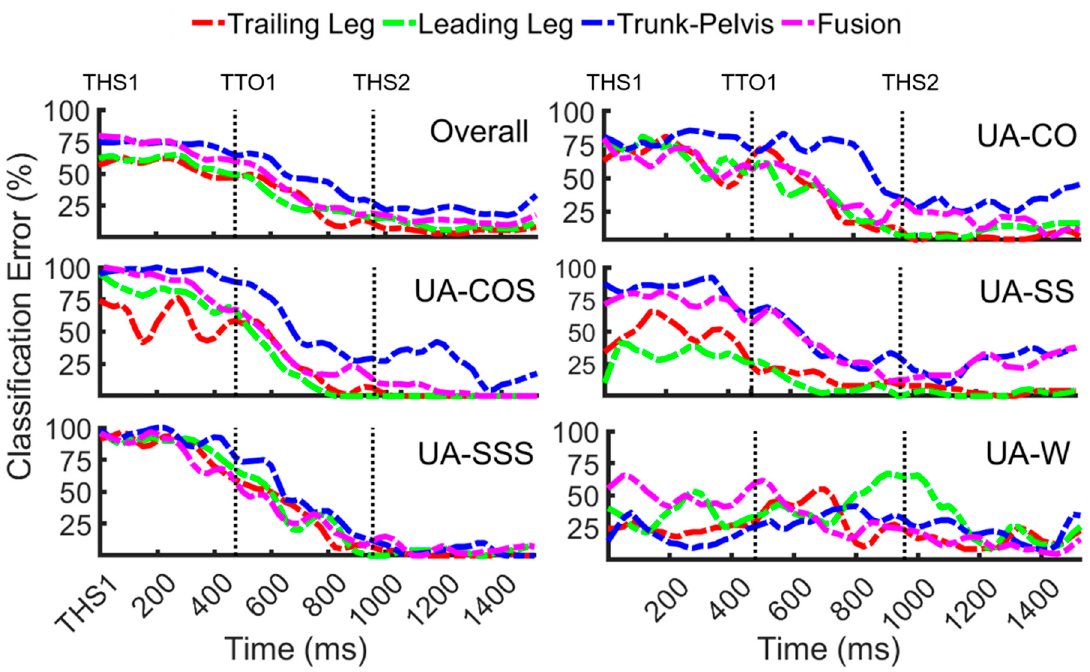
Figure 5. Classification error over time for unanticipated locomotor transitions (UA-CO, UA-COS, UA-SS, UA-SSS, and UA-W) as well as overall error across transitions using biomechanical signals from the trailing leg, leading leg, trunk-pelvis and their fusion. Each trial was initiated with the first trailing leg heel strike (THS1). Subjects entered a locomotor transition at (TTO1), and transition ended with the second trailing leg heel strike (THS2).